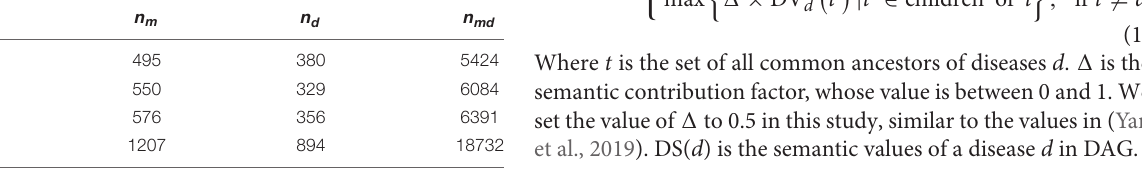
TABLE 1 | The number of MiRNAs, diseases and miRNA-disease associations in four datasets.